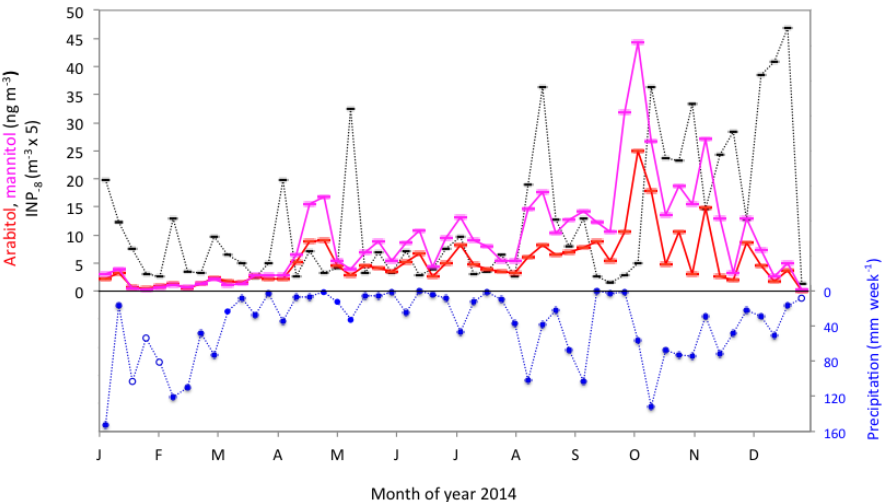
Figure 5. Weekly concentration of arabitol (red) and mannitol (magenta). The time courses of INP − 8 in PM 10 (black; × 5, to fit onto the same scale) and precipitation (blue) are copied from Fig. 1 to facilitate direct